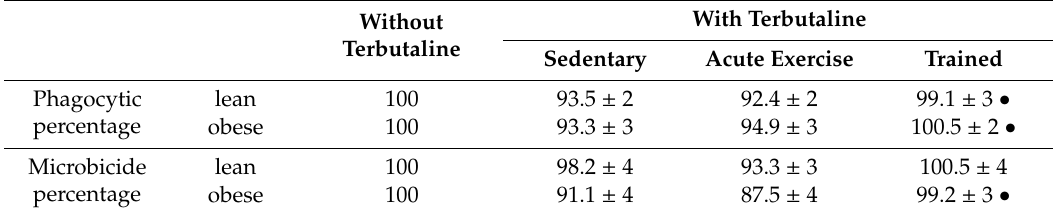
Table 4. Influence of exercise on the relative e ff ect of the β 2-adrenergic agonist terbutaline on the phagocytic and microbicide percentages of peritoneal macrophages from lean and obese mice (sedentary, acute exercise, and trained mice) (giving 100 to control values in the absence of terbutaline).